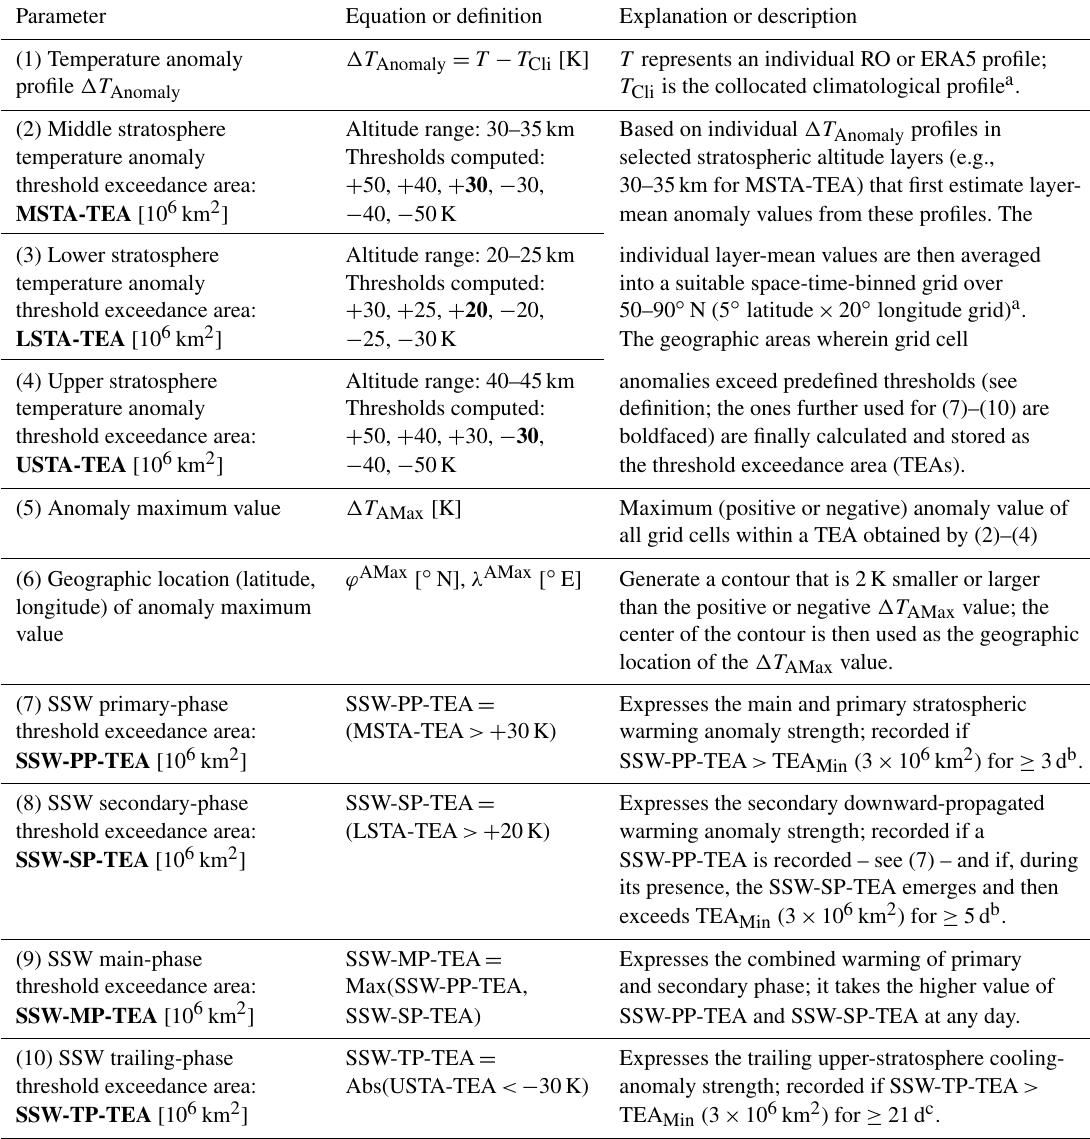
Table 1. Basic parameters and methodology of the new SSW monitoring approach – all parameters are updated daily; the boldfaced font in (2)–(4) and (7)–(10) marks key parameters for the monitoring, as also shown in Figs. 7 to